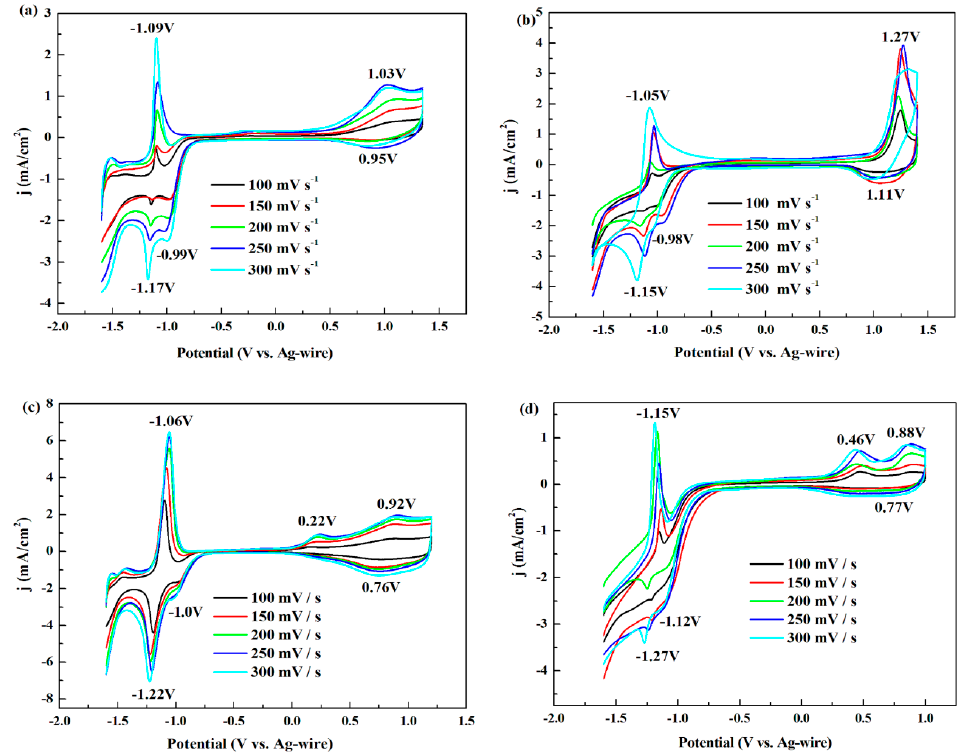
Figure 2. CV curves of the polymers for p-doping and n-doping processes at various scan rates: ( a ) P1; ( b ) P2; ( c ) P3; and ( d )